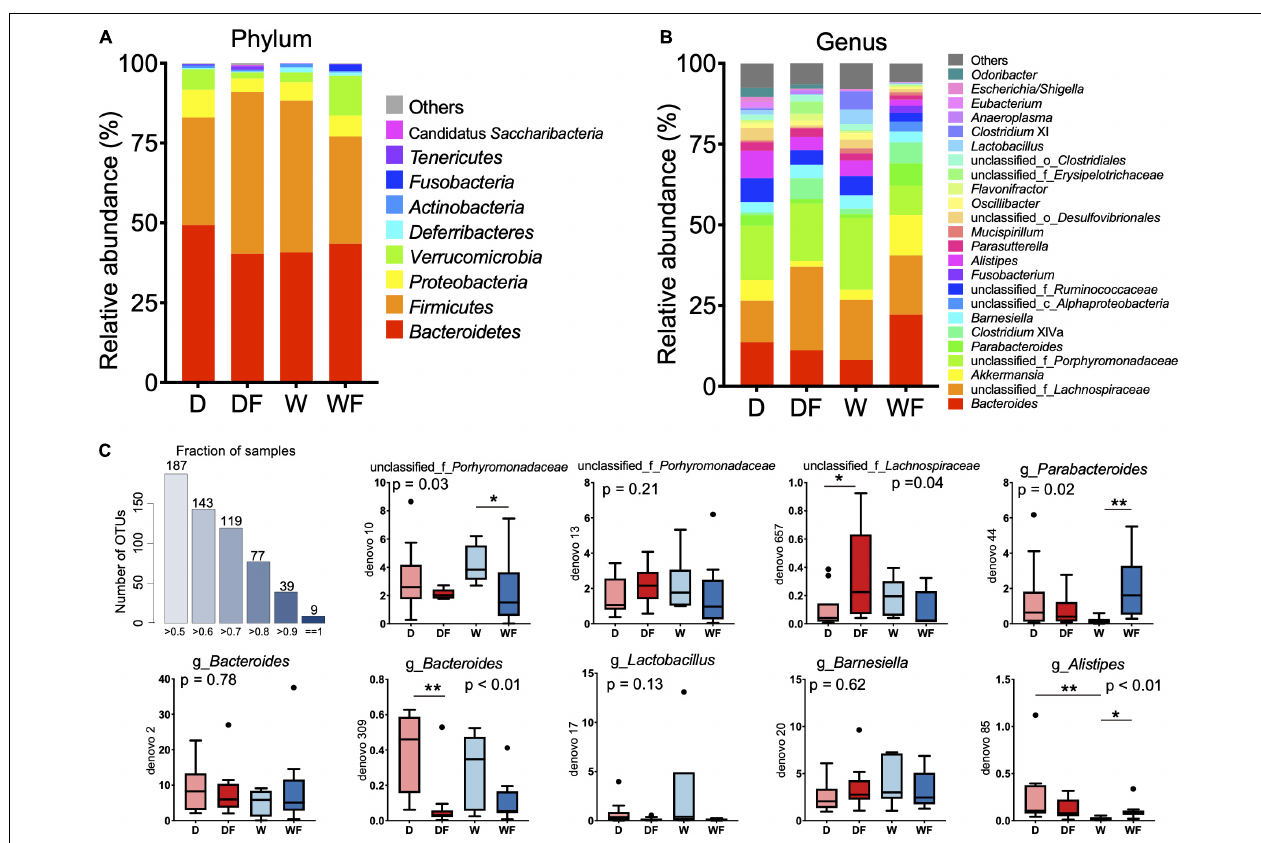
FIGURE 4 | Relative abundance of gut microbiota in mice transplanted domestic pig fecal bacteria and feed a low-fiber diet (D) or high-fiber diet (DF), transplanted wild boar fecal bacteria and feed low-fiber diet (W) or high-fiber diet (WF). (A) Gut microbiota in mice of four groups at phylum level with relative abundance over 0.1% in at least one group was shown. (B) Gut microbiota in mice of four groups at genus level with relative abundance over 1% in at least one group was shown. (C) Boxplot of relative abundance of nine OTUs existed in gut of all individuals. * p < 0.05, ** p <